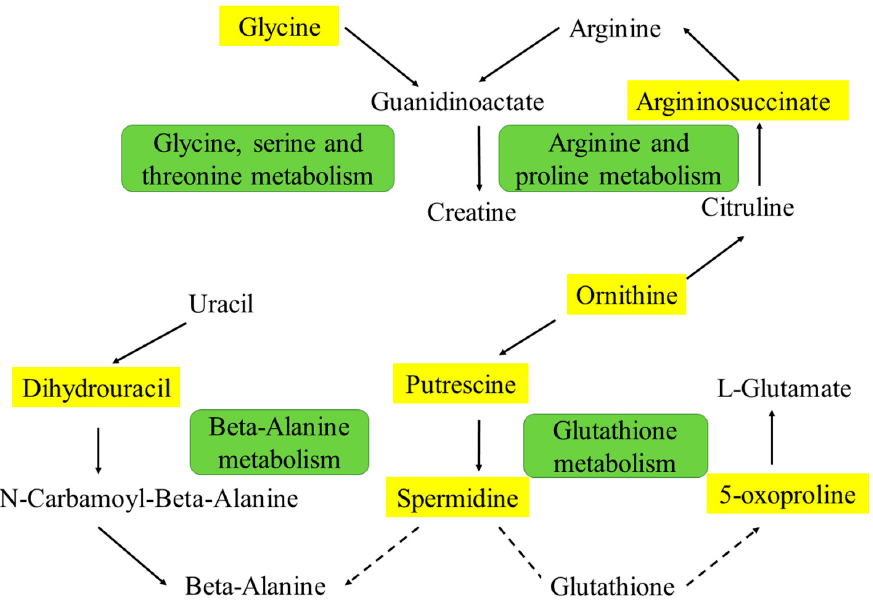
Figure 5. Correlation networks of all the potential biomarkers in LPS stressed and amentoflavone treated cells. Metabolites in yellow boxes represent altered biomarkers determined by UPLC/QTOF-MS. The green boxes represent the pathway including the metabolites around.